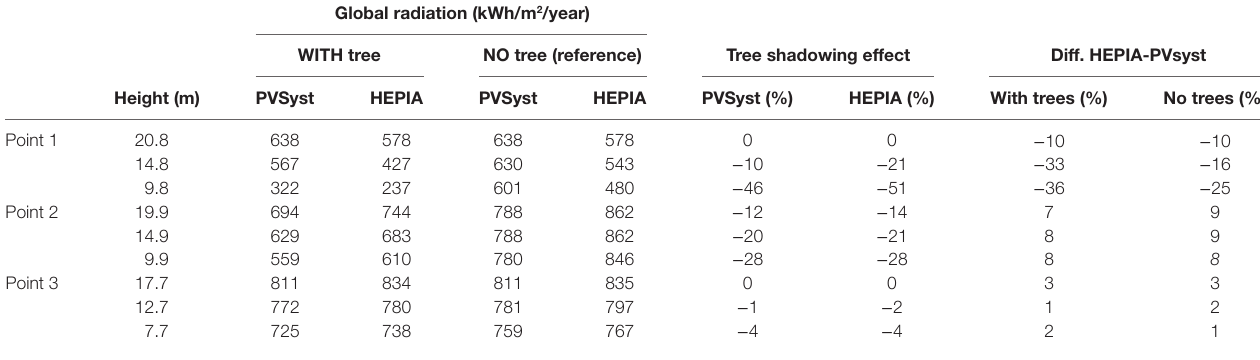
tABLe 2 | Results of comparison of global radiation values in the collector plane (in kWh/m 2 /year) between the solar model described in this work (hepia) and the simulation using PVsyst (HESSO-Valais) with and without trees’ consideration. The height values are given with respect to the building ground level. Global radiation (kWh/m 2 /year) WIth tree tree shadowing effect diff.